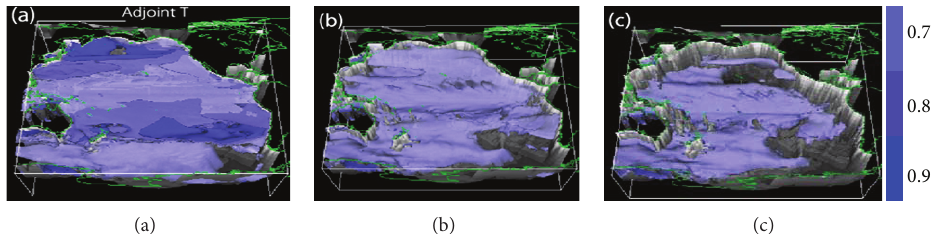
Figure 2: Sensitivity of heat content in the Pacific Ocean at an allocated model time (defined as year zero) when water temperature changes by +1K at an arbitrary 4-dimensional grid point. The panels show the impact of the change in subsurface water temperature on the heat-content increase after (a) 10 years, (b) 30 years, and (c) 50 years. The units are